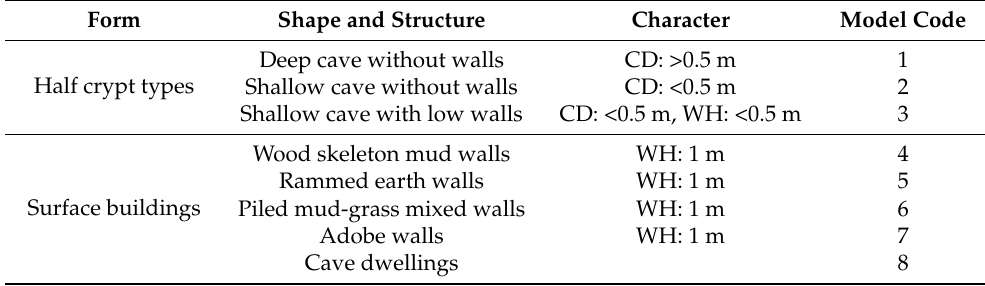
Table 3. Size classification of the ancient houses. (the model code is the same as in Figure 4). Types Small House Medium House Large House Area <20 m 2 20–60 m 2 60–200 m 2 >200 m 2 Model code A B C D